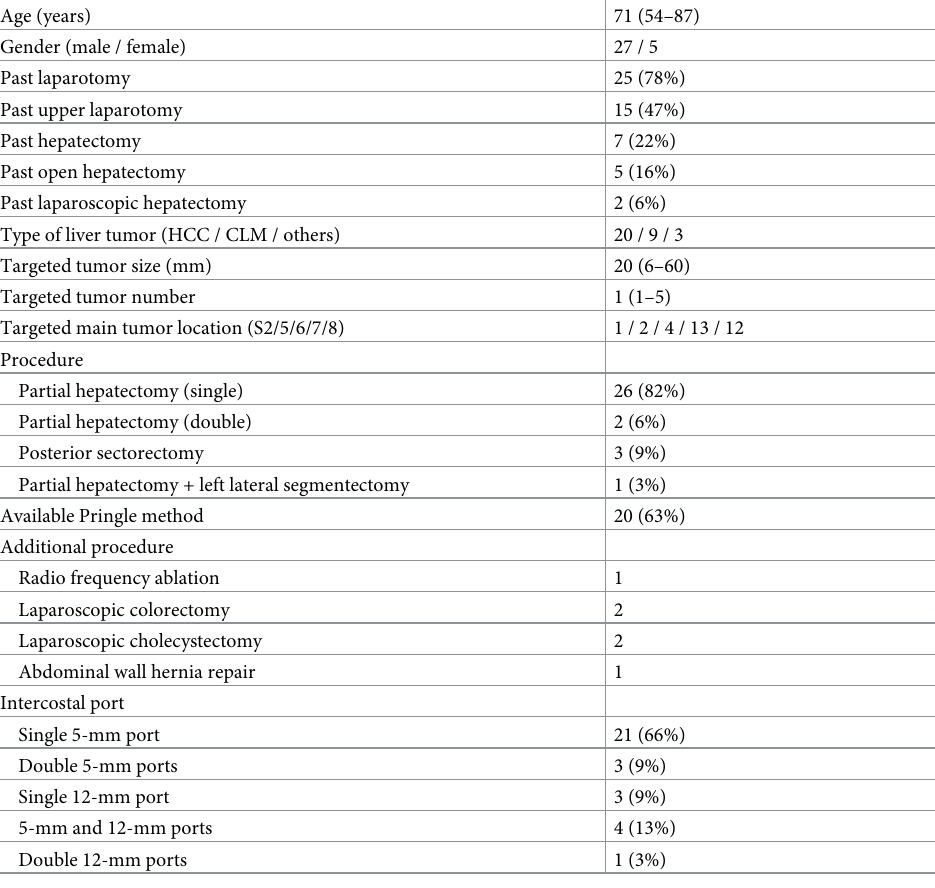
Table 1. Background characteristics of patients with intercostal trocars in laparoscopic hepatectomy (N =